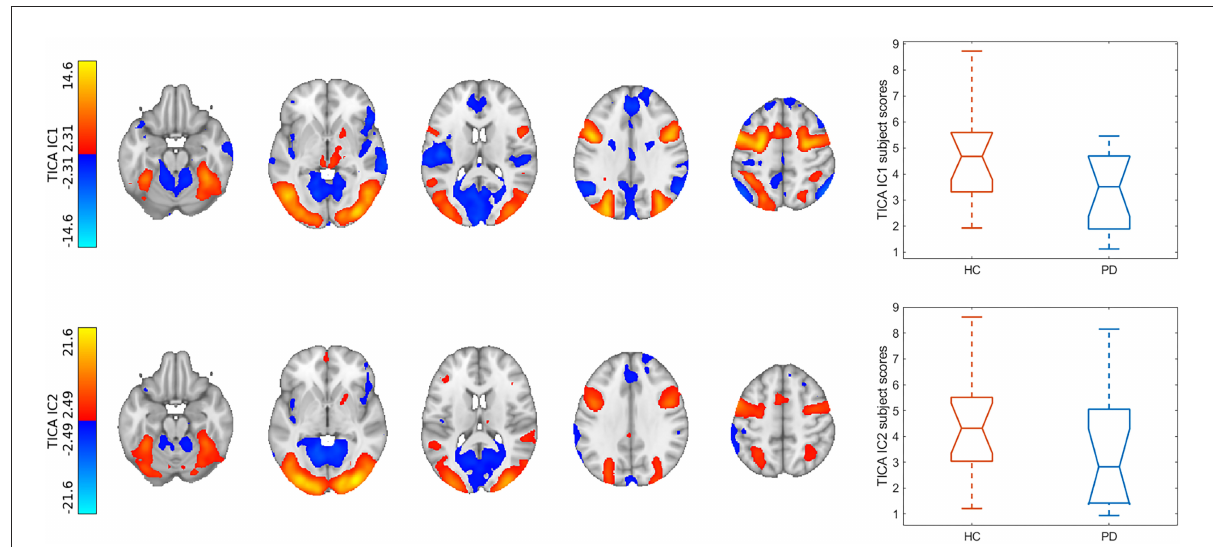
FIGURE2 Results of the multivariate analysis. Spatial maps of task-relevant components were upsampled to 1mm resolution and overlaid on the MNI152 1mm template. Color bars denote Z -statistics. Box plots show group differences in subject modes of corresponding components. TICA, tensorial independent component analysis; IC, independent component; HC, healthy control; PD, Parkinson’s disease.